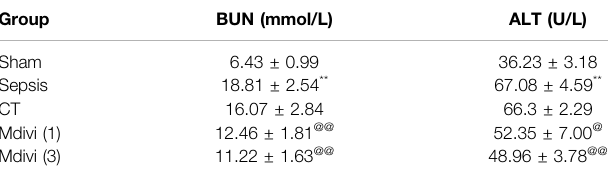
TABLE 1 | Effects of Mdivi-1 on liver and kidney function in septic rats ( n (cid:1) 8).